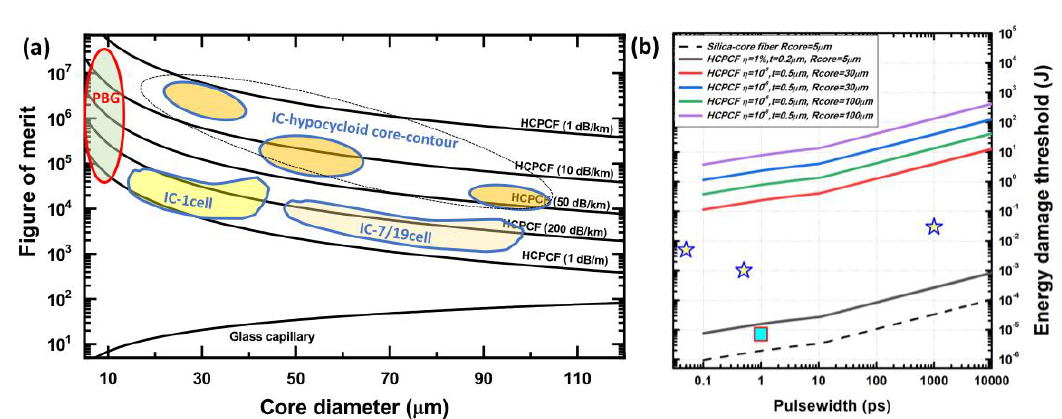
Figure 24. ( a ) Laser–gas interaction figure of merit evolution with the hollow core diameter for glass capillary and different HCPCF transmission loss figures. ( b ) HCPCF-guided laser energy damage threshold for different types of HCPCF. The star and square symbols are the experimental demonstrated energy with IC-HCPCF-guided lasers [31,99,100] and PBG-HCPCF [101],